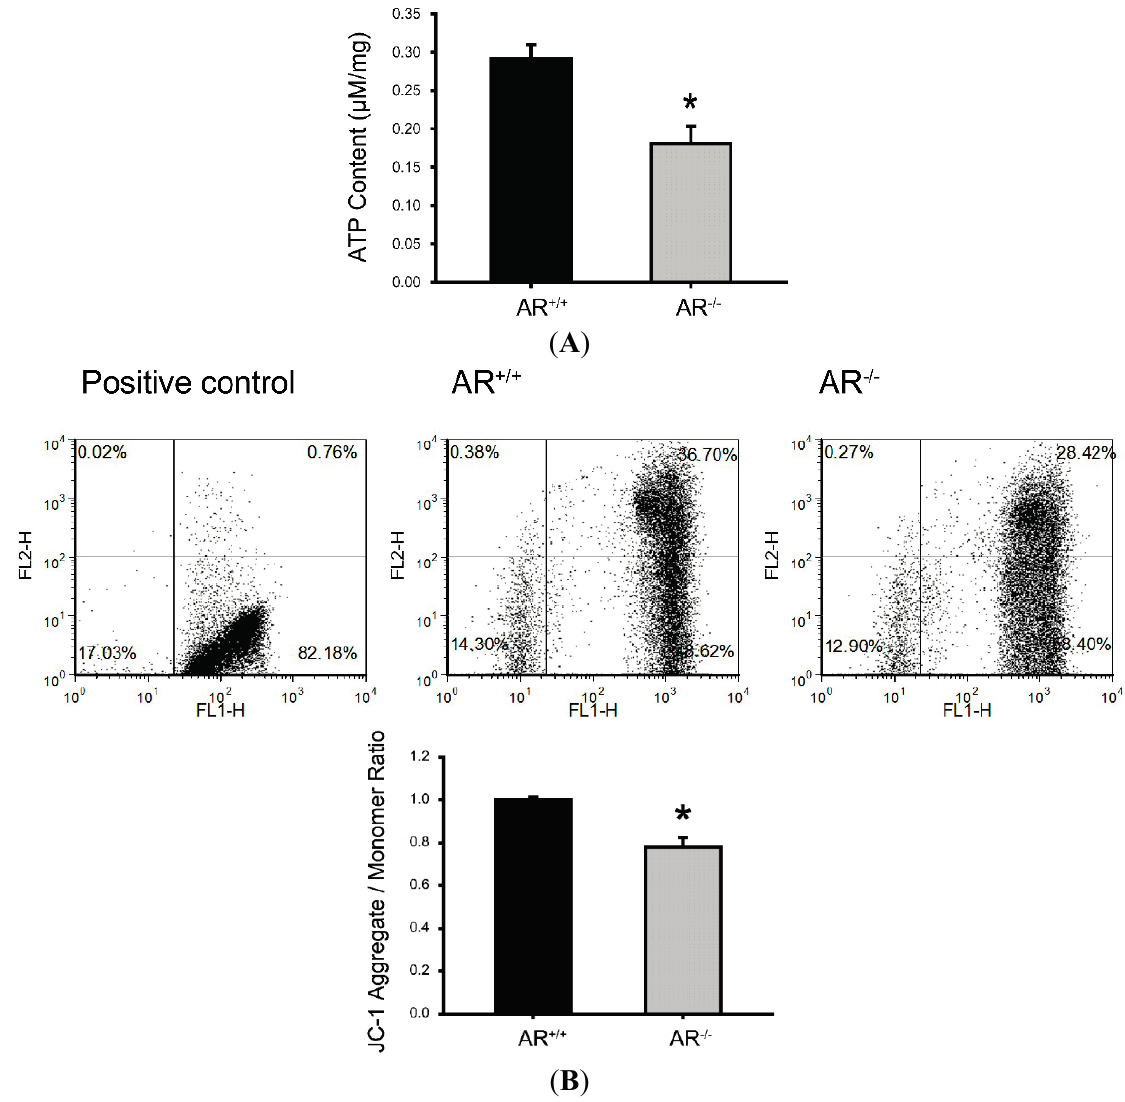
Figure 5. Metabolic dysfunction of mitochondria and reduced mitochondrial membrane potential in granulosa cells of AR − / − mice. ( A ) Reduced ATP content in granulosa cells of AR − / − mice. Granulosa cells removed from AR +/+ and AR − / − mice were collected to determine the levels of ATP. Values are expressed as µM per mg protein. Histogram shows the average ATP content in granulosa cells from AR +/+ and AR − / − mice. * p < 0.05, n = 3 mice per genotype; ( B ) Detection of mitochondrial membrane potential by flow cytometry analysis of JC-1 staining. Granulosa cells were collected from 4-week-old female mice ( AR +/+ and AR − / − ) injected with 48 h of 7.5 IU pregnant mare’s serum gonadotropin (PMSG) treatment, and then stained with 5,5',6,6'-tetrachloro-1,1',3,3'-tetraethylbenzimidazolylcarbocyanine iodide (JC-1). JC-1 exists as a monomer in the cytosol (green fluorescent) and also accumulates as aggregates in the mitochondria (red fluorescent). In apoptotic and necrotic cells, JC-1 exists in monomeric form and stains the cytosol green. Results are expressed as the ratio of the aggregate to monomeric form of JC-1. The percentage is expressed as the mean ± SD ( n = 3 mice per genotype). * p <